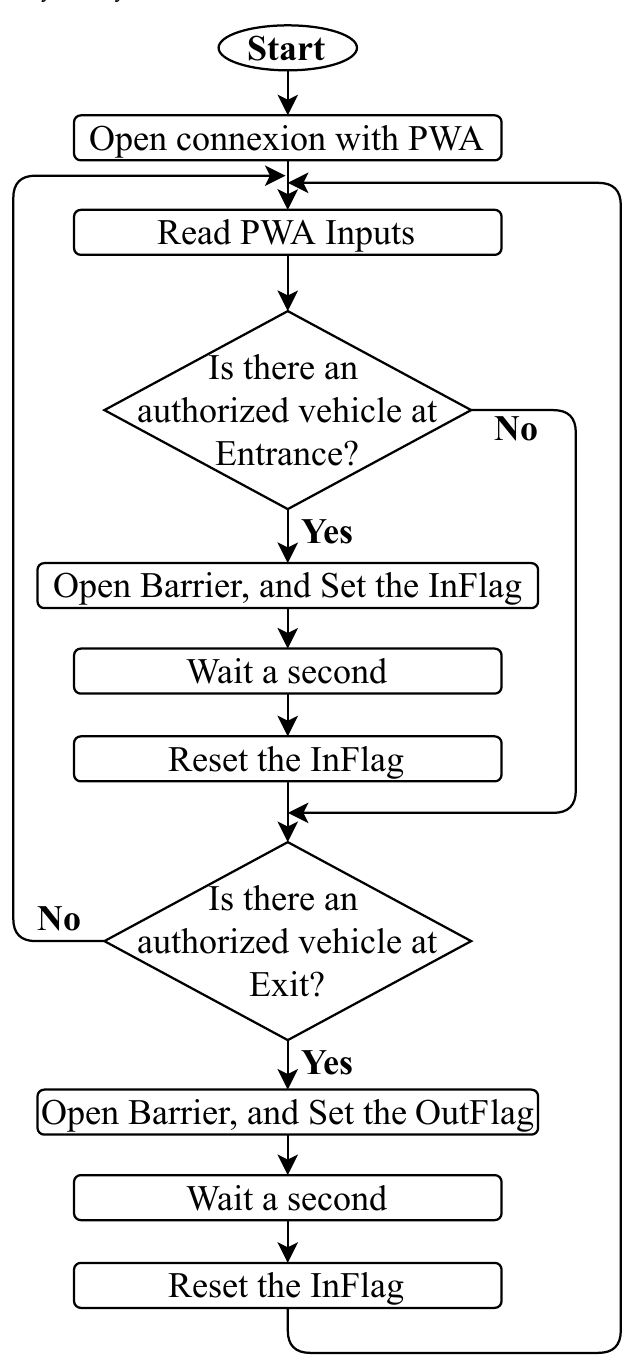
Figure 12. Flowchart of the Parking Web Automate